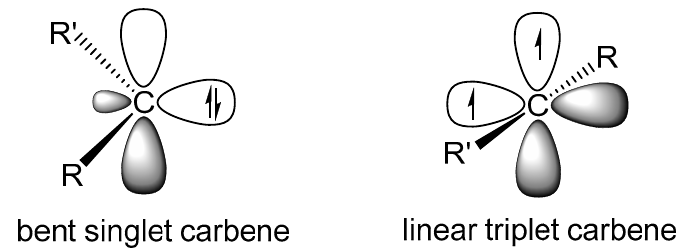
Figure 2. General structural representation of a singlet carbene and a triplet carbene.